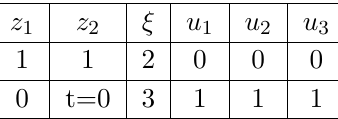
Table 3 . Scaling relations for toric ambient space X 4 of Calabi-Yau double cover X 3 associated with B 3 = P 1 (cid:2) P 2